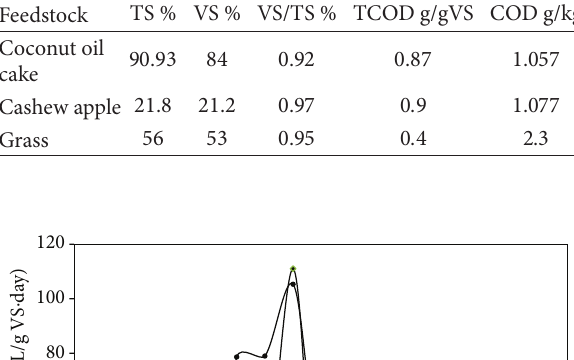
Table 1: Composition of solutions. Table 2: Characteristics of substrates. Feedstock